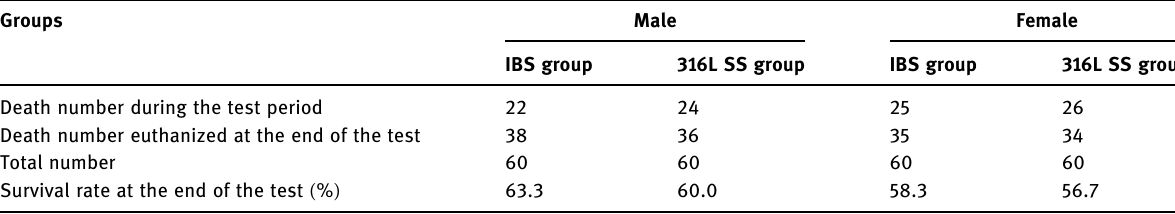
Table 1: Death of test group and control group